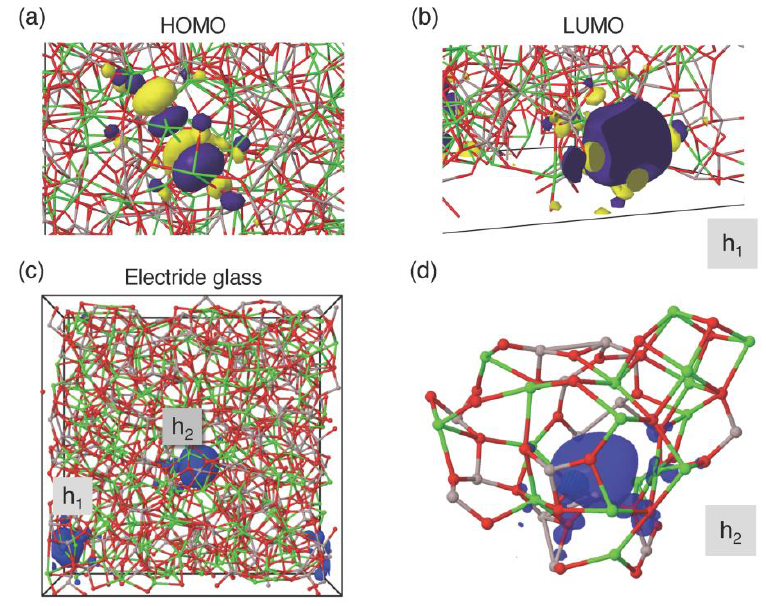
Figure 8. Close-up visualizations of ( a ) highest occupied molecular orbital (HOMO) and ( b ) lowest unoccupied molecular orbital (LUMO) single-particle electron states in the 64CaO glass. The parameter h 1 indicates the cavity (cage) occupied by the LUMO. Yellow and magenta represent the different signs of the wave-function nodes. ( c ) Simulation box and the electron spin density of the 64CaO glass with one oxygen removed at h 2 , i.e. with two additional electrons. ( d ) Cage structure around the spin density of one electron corresponding to the h 2 cavity (close-up of ( c )). Al: gray; Ca: green; O: red [16].